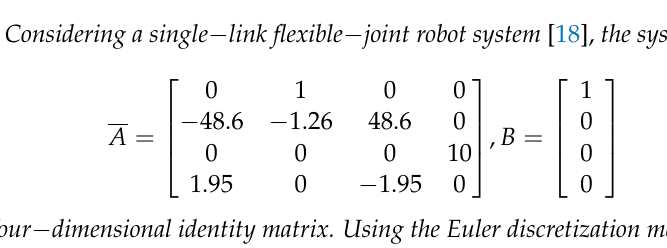
Figure 1. Error vector and parameter response trajectories for the error system in Example 1.